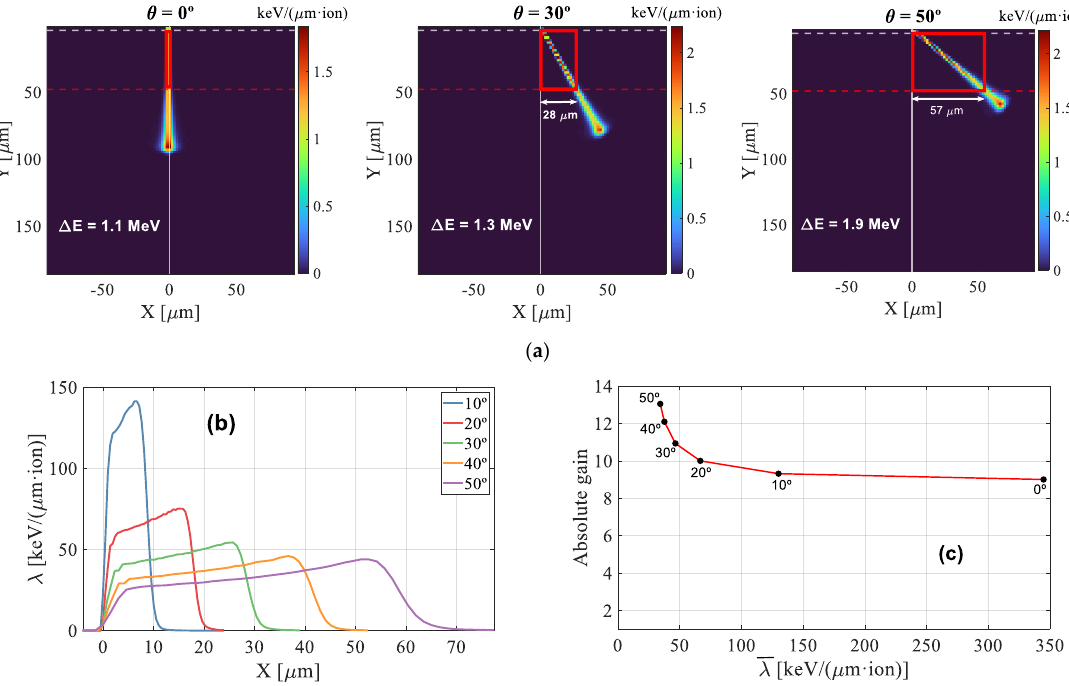
Figure 12. ( a ) SRIM simulations of the energy deposited by a 3 MeV proton beam entering from the top with an incident angle of 0 ◦ , 30 ◦ and 50 ◦ . The red dashed line indicates the end of the active layer. ( b ) Profile of the ionization density projected on the x axis for angles up to 50 ◦ . ( c ) Absolute gain versus the mean linear ionisation density at 130